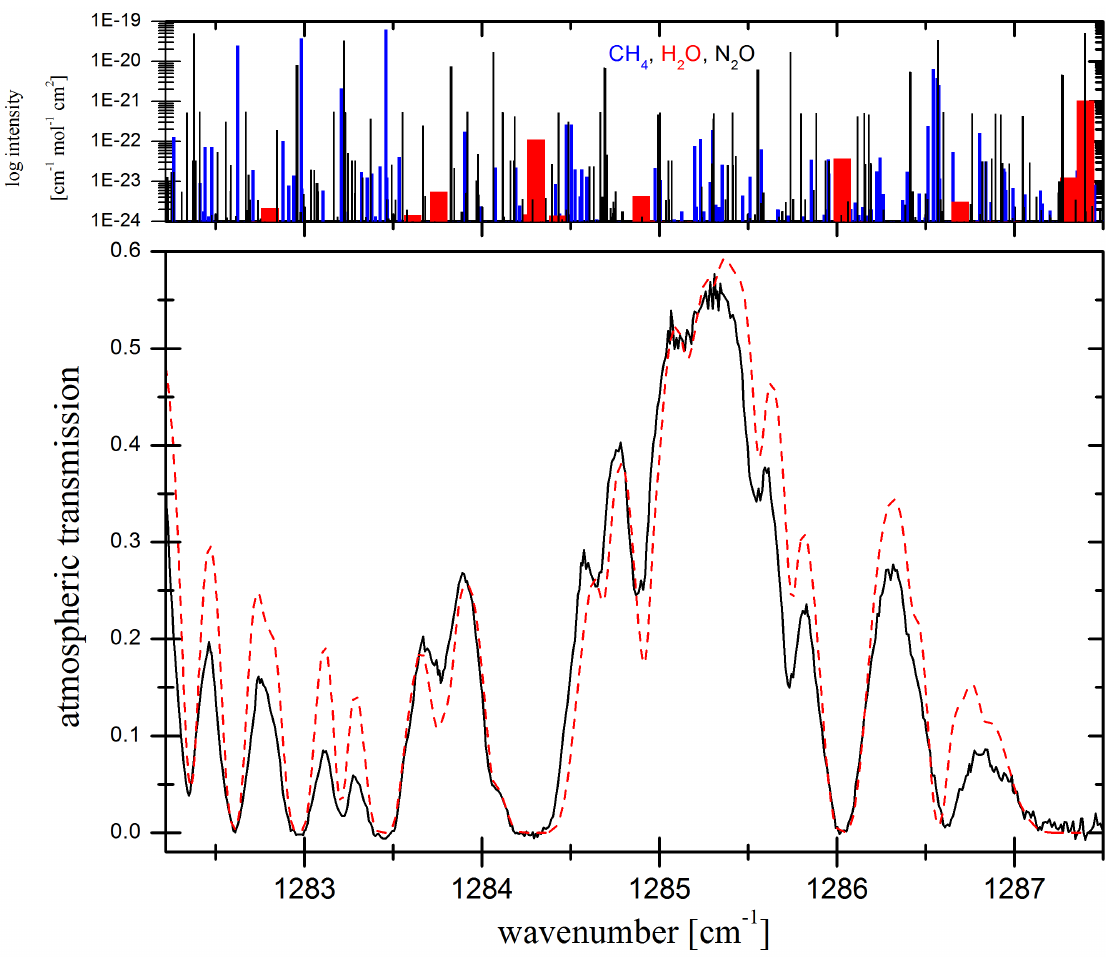
( Top ) Molecular transitions of the, in the probed spectral range predominant, atmospheric constituents, nitrous oxide, N O (black), water, H O (red), and methane, CH 2 2 4 (blue). ( Bottom ) The atmospheric transmission above the McMath-Pierce Solar Telescope (black) compared to the mid-summer latitude model of the terrestrial atmosphere